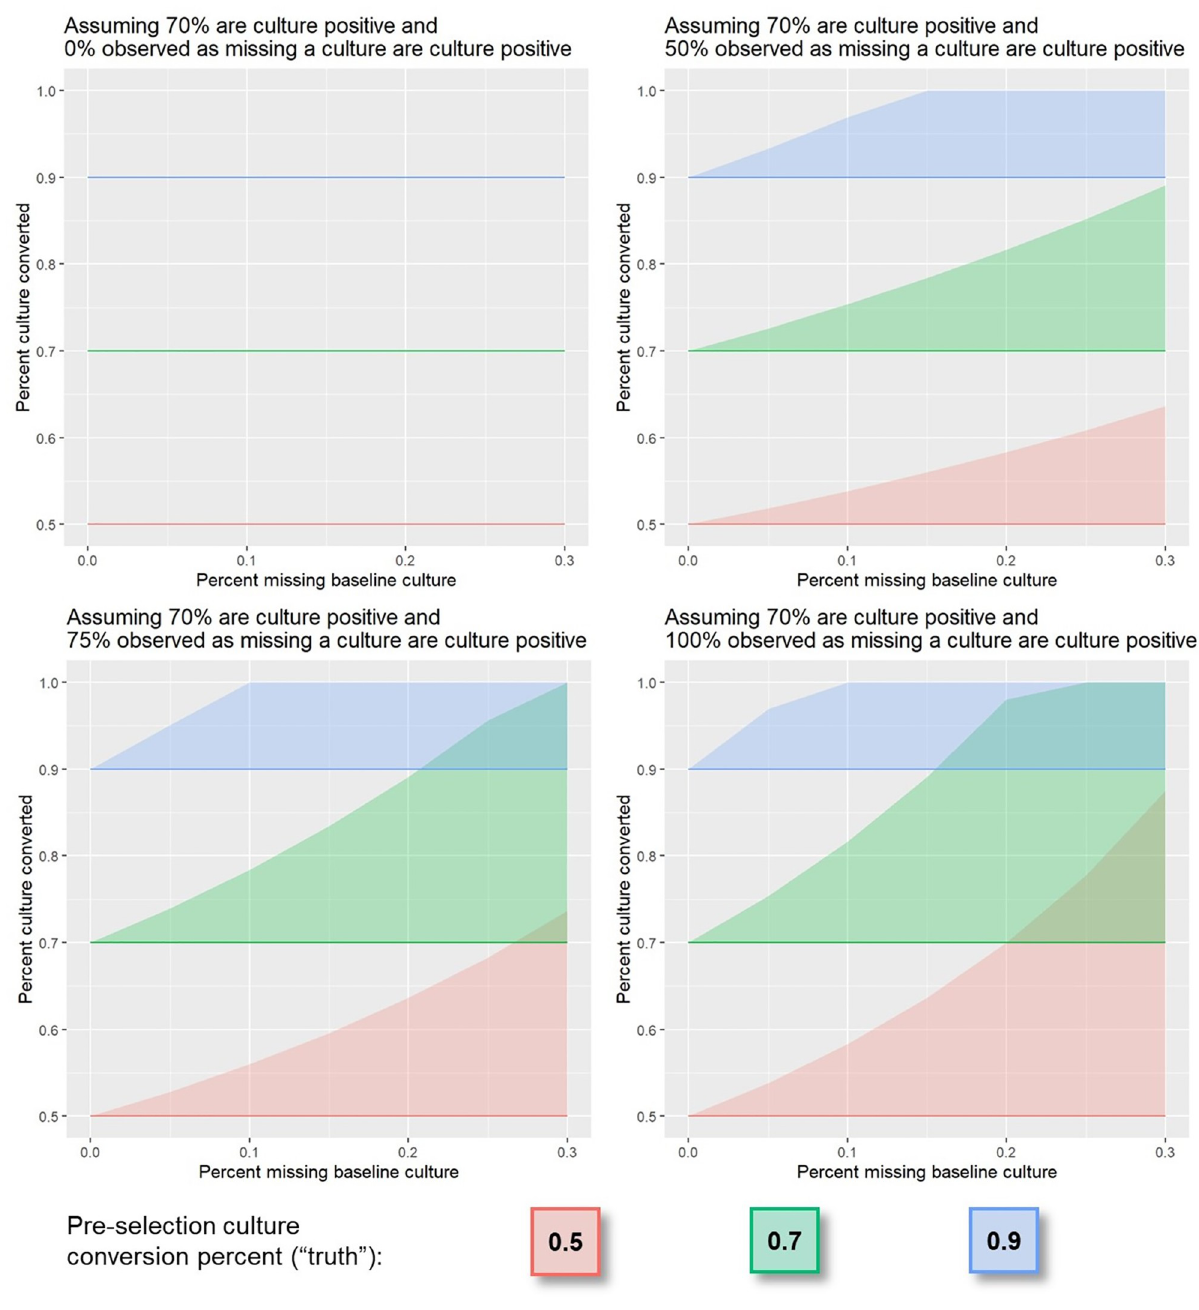
Fig 4. Culture conversion among participants missing a pre-treatment culture, simulation study of cohort where P t = 70%, P t │ m is varied from 0–100% and C │ P t = 50%, 70%, or 90%. The maximum magnitude of bias (top of each shaded region) is dependent on the proportion of patients who are culture positive among those missing a pre-treatment culture (each panel). If no (0%) patients missing a pre-treatment culture are culture positive, then these patients would be excluded from the analysis and no bias will be introduced (top left). Conversely, if all (100%) patients missing a pre- treatment culture are culture positive, then these patients should be included and the most potential for bias introduced (bottom right).